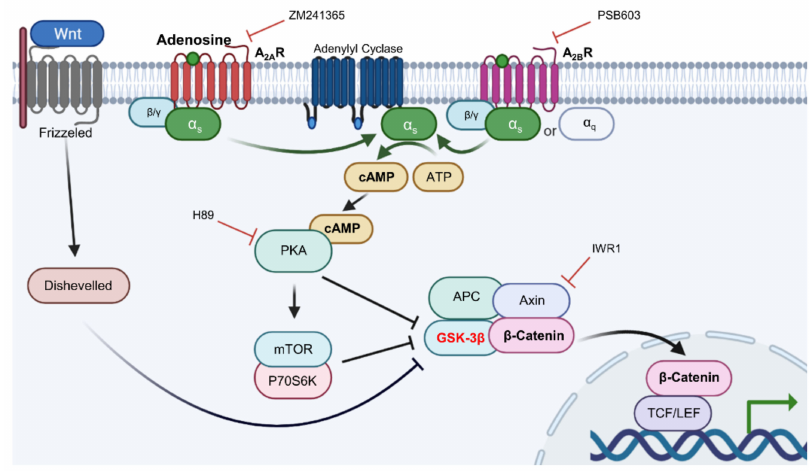
Figure 9. The proposed signal transduction pathways for adenosine-induced Wnt/ β -catenin signal